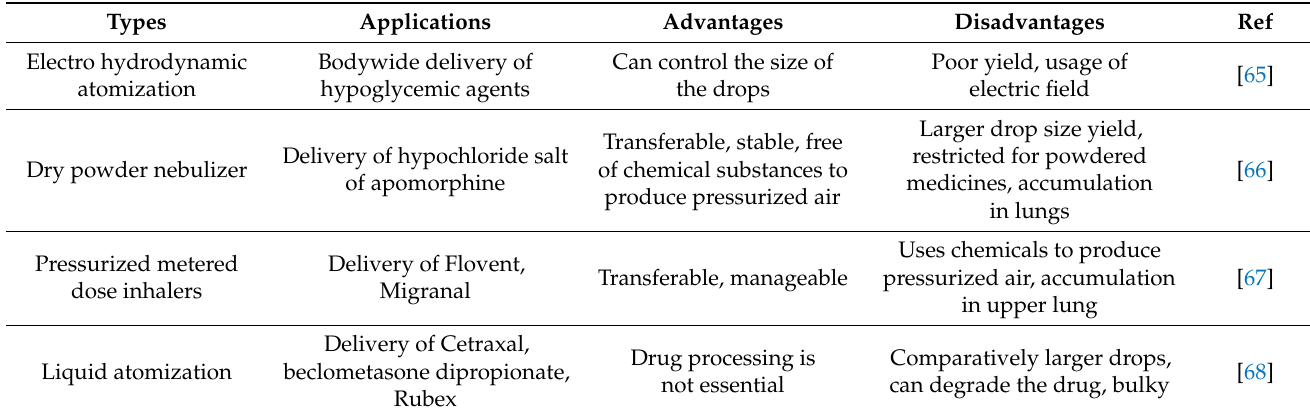
Table 3. Types of aerosol initiating